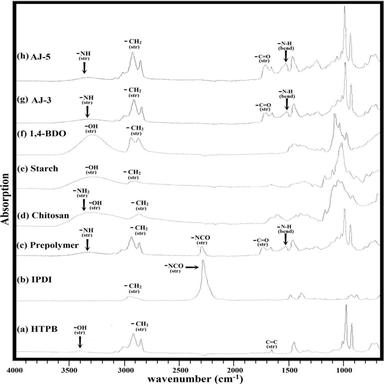
FTIR presentation of monomers, individual steps and Final polymers (AJ-3 and AJ-5).